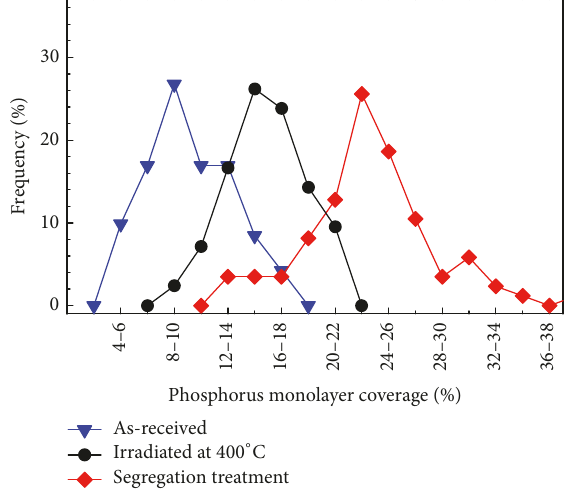
Figure 12: Grain boundary concentration of phosphorus in 15Kh2NMFAA steel specimens: as-received, after segregation pro- voking treatment, and after irradiation at 400 ∘ b